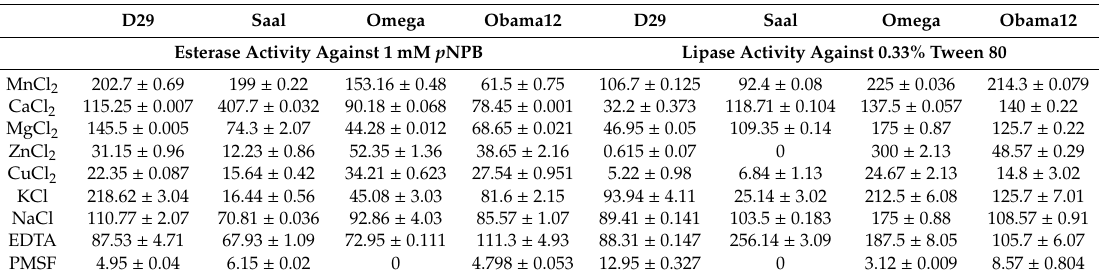
Table 3. Effect of different additives including metal ions, EDTA and phenylmethane sulfonyl fluoride (PMSF) on the esterase and lipase activities of LysB-His 6 enzymes against 1 mM p NPB and 0.33% Tween 80, respectively. D29 Saal Omega Obama12 D29 Saal Omega Obama12 Esterase Activity Against 1 mM p NPB Lipase Activity Against 0.33% Tween 80 MnCl